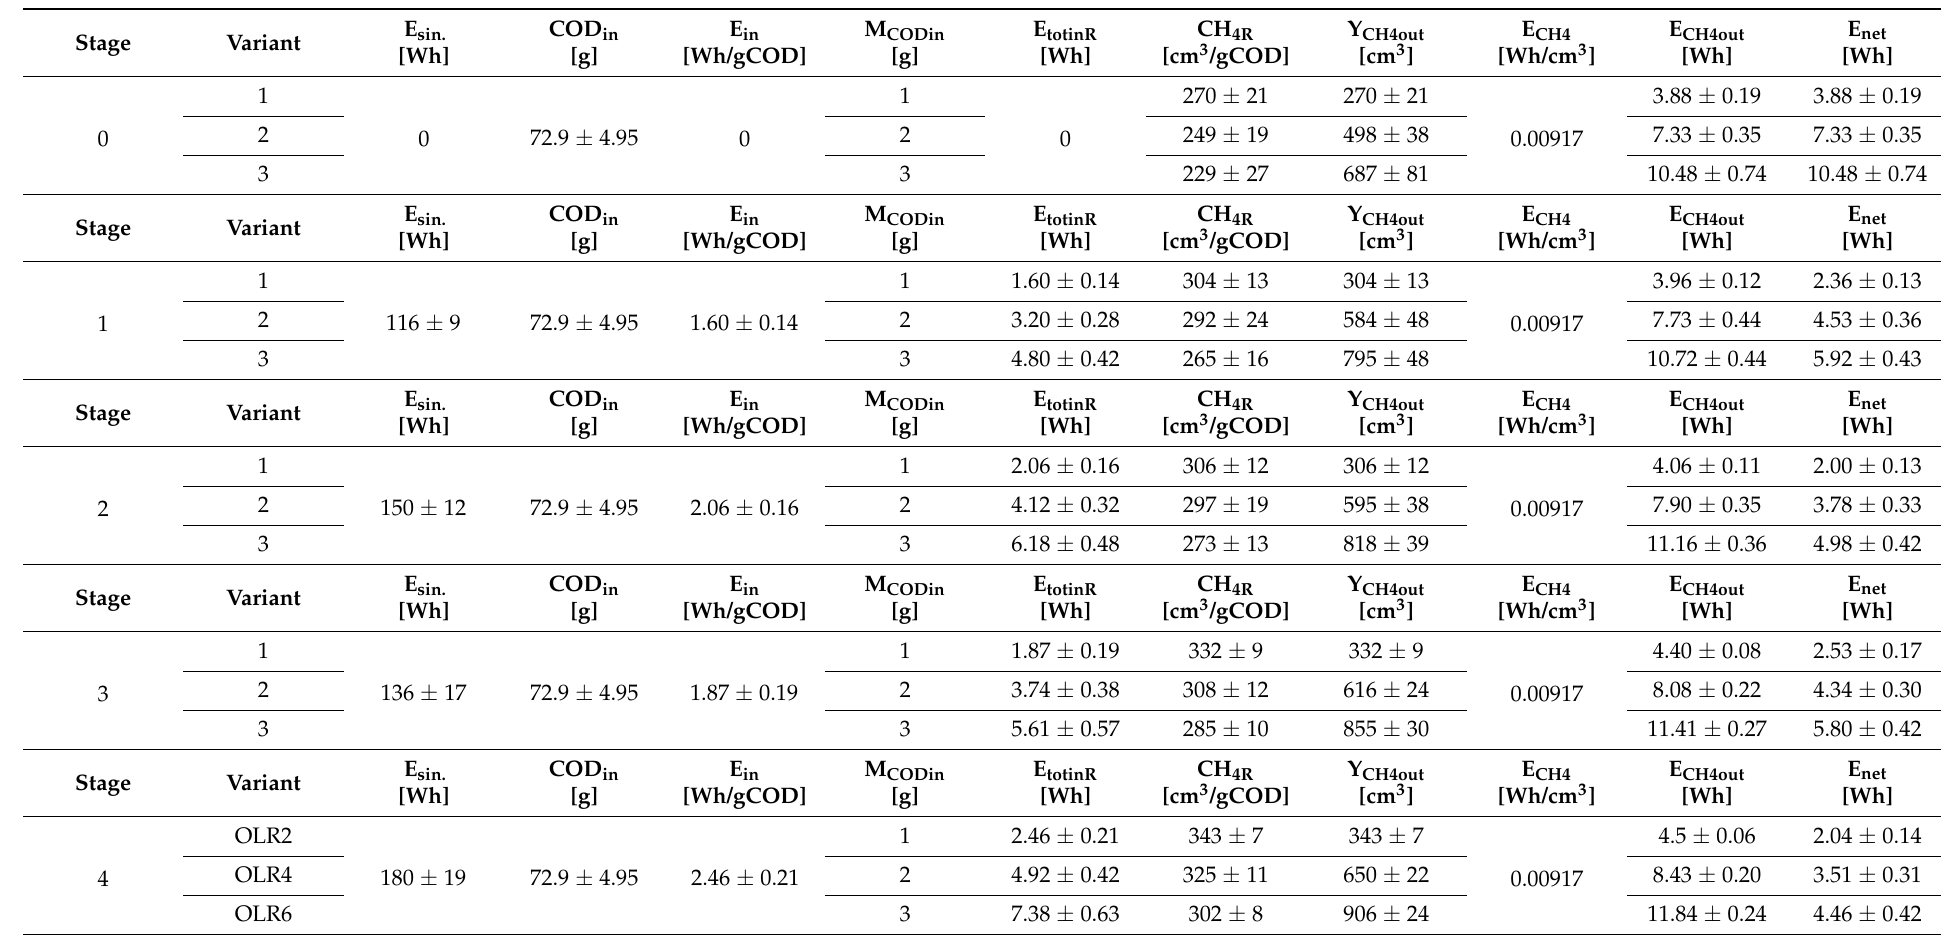
Table 5. Energy balance of thermal pre-treatment of H-LSPW in individual experimental